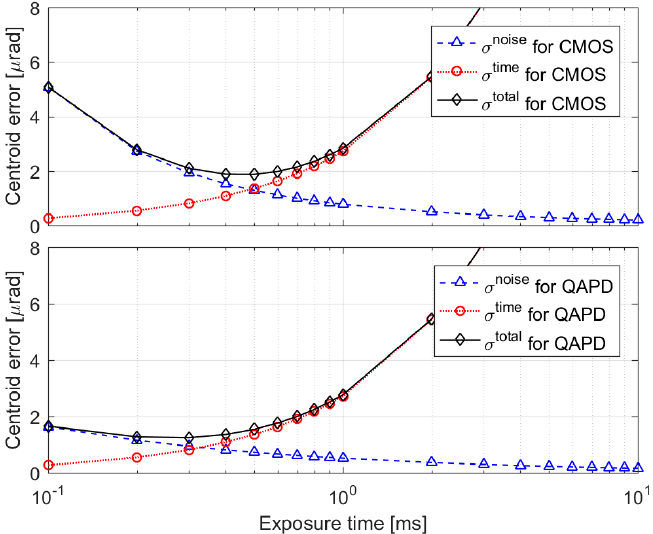
Figure 5. Total centroid error under weak atmospheric turbulence conditions.